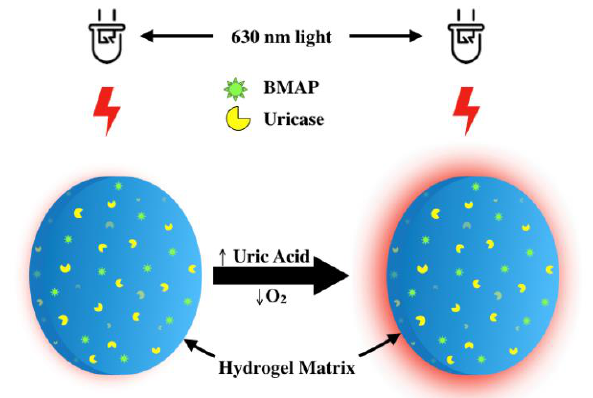
Figure 2. Illustration of the urate biosensing mechanism based on enzyme-induced oxygen depletion coupled with oxygen-responsive phosphors immobilized in a biocompatible hydrogel matrix. Urate concentration is proportional to phosphorescence intensity and lifetime.